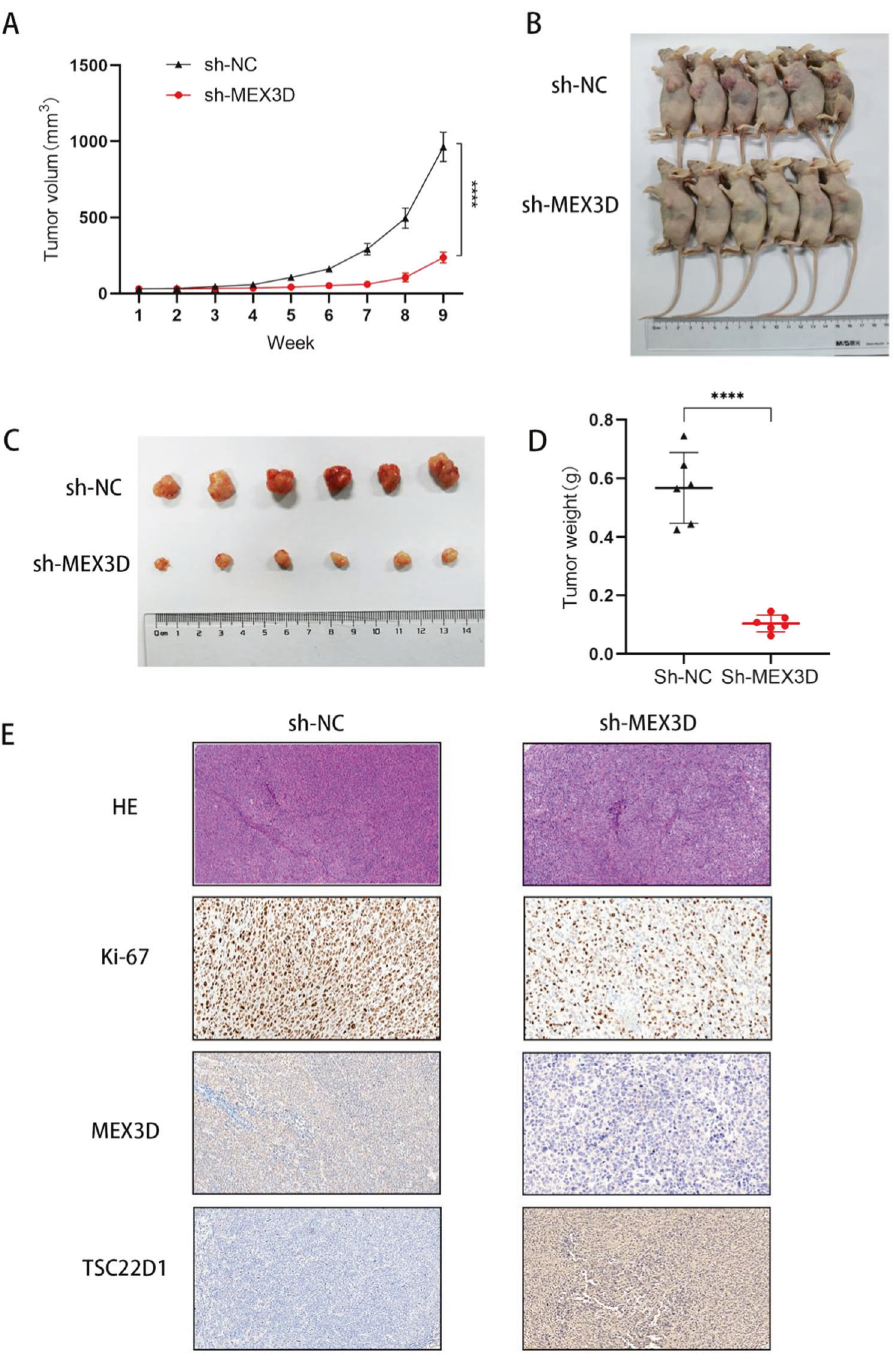
Fig. 5 MEX3D expression knockdown reduces the growth of xenograft tumor. Non-SCID mice were injected with SiHa/NC-shRNA and SiHa/ MEX3D-shRNA cells subcutaneously. Tumor volume was estimated every 7 days, and all mice were euthanized under general anesthesia 9 weeks following injection. A SiHa/MEX3D-shRNA cells grow at a signi fi cantly slower rate than SiHa/NC-shRNA cells. B Representative images of mice euthanized at week nine following injection ( n = 6). C Macro images of subcutaneous tumors. D Subcutaneous tumor weights in naked mice using sh-MEX3D or a negative control. E H&E, Ki-67, MEX3D, and TSC22D1 protein expression in xenograft tumors were analyzed by IHC. **** P < 0.0001. (Fig. 5E). To establish if MEX3D was capable of regulating cell non-SCID mice was done. SiHa/MEX3D-shRNA cell growth was proliferation in vivo, the Ki-67 antigen expression levels (a well- signi fi cantly lower than SiHa/NC-shRNA cell growth (Fig. 5A). In known cellular proliferation markers) were estimated utilizing IHC. addition, both the tumor size and weight of the animals injected As listed in Fig. 5E, in tumors obtained through SiHa/MEX3D- with SiHa/MEX3D-shRNA cells were lowered signi fi cantly com- shRNA cells, a smaller number of Ki-67 antigen-positive cells was pared to the tumors obtained through the SiHa/NC-shRNA cells observed than in tumors obtained through SiHa/NC-shRNA cells. (Fig. 5B – D). H&E staining was conducted to con fi rm tumorigenesis